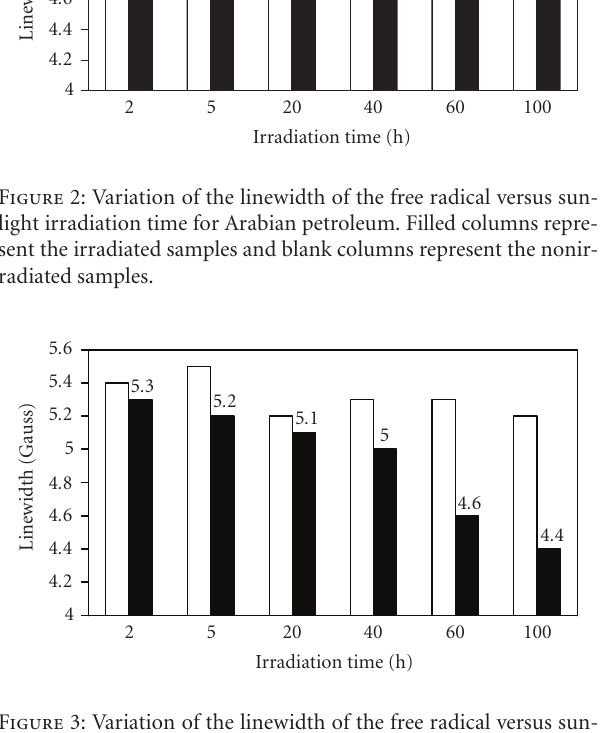
Figure 3: Variation of the linewidth of the free radical versus sun- light irradiation time for Colombian petroleum. Filled columns represent the irradiated samples and blank columns represent the nonirradiated samples.